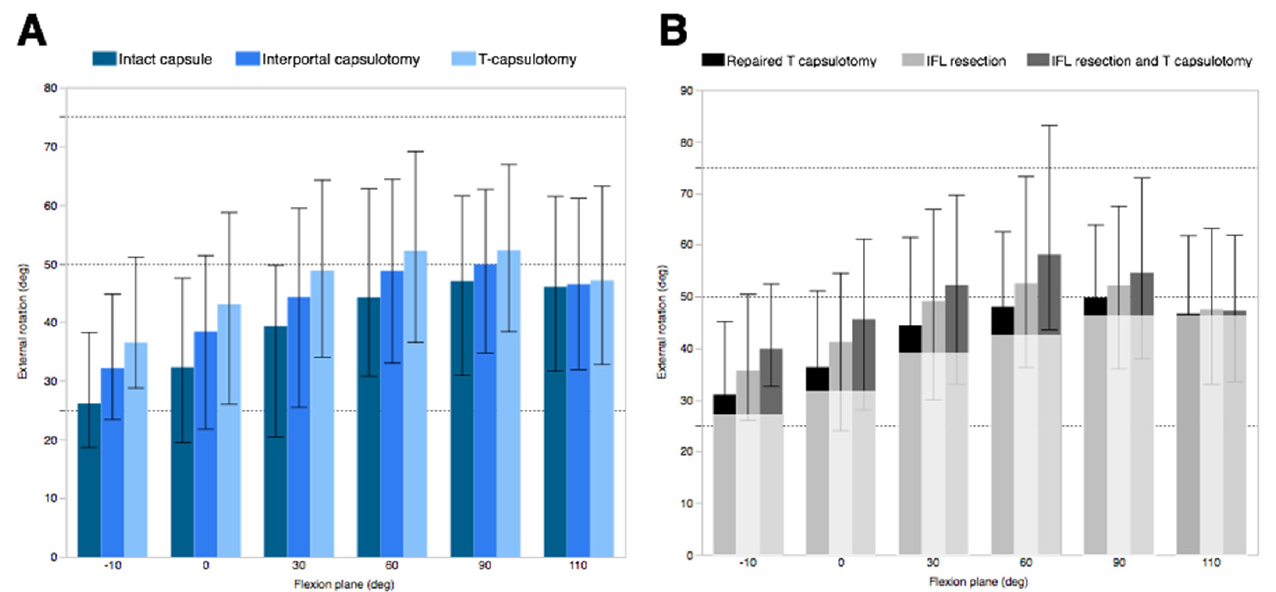
Figure 4. External rotation measured at different flexion angles to compare ( A ) conventional cap- sulotomy and ( B ) different IFL and ZO conditions. The lighter-colored box in panel B indicates the external rotation of the intact condition.